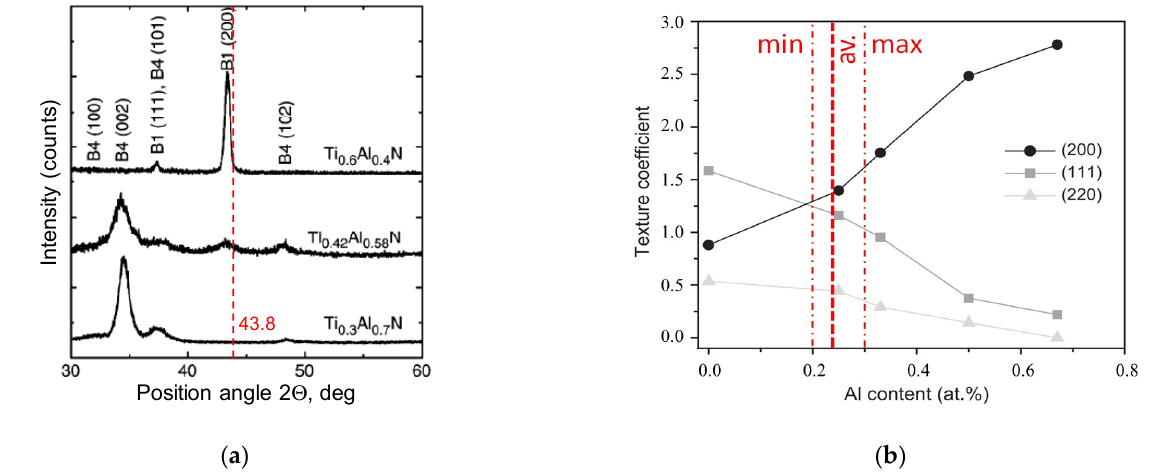
Figure 15. XRD patterns of TiAlN coatings with various atomic ratios (Ti:Al) ( a ) and the influence of Al at.% content on Ti1-xAlxN coating texture ( b ) with experimental data presented in Figure 13a,b (diagrams were elaborated based on Refs. [18,19]).